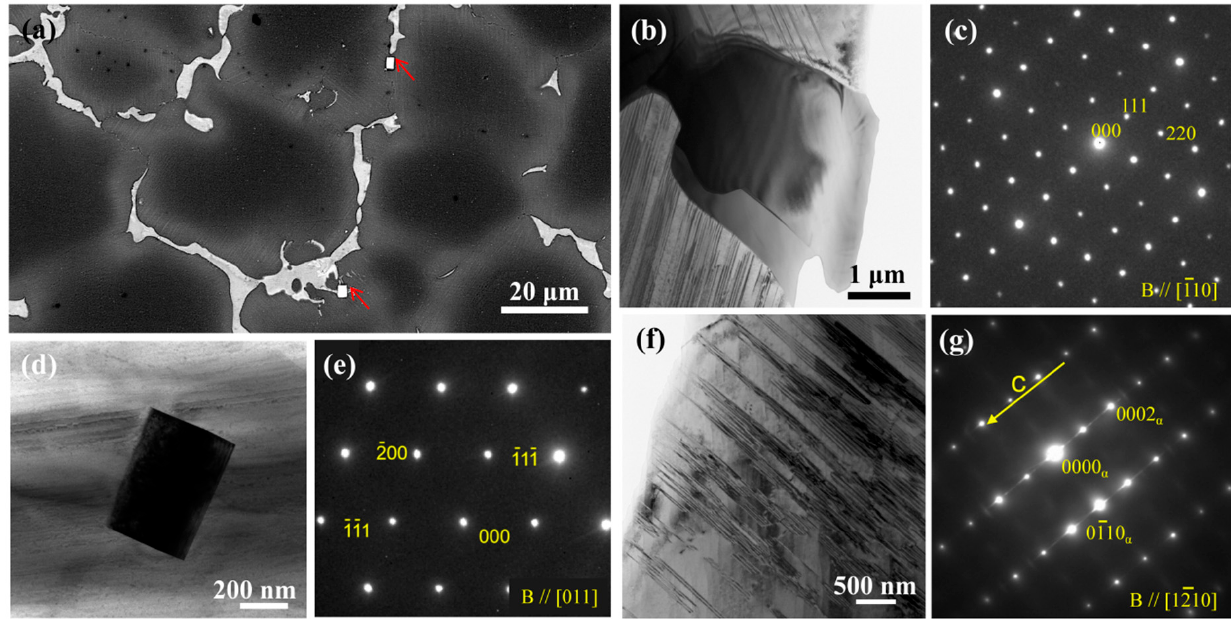
Figure 3. Initial microstructure of the as-cast EQ142X alloy: ( a ) SEM image; ( b – g ) bright-filed TEM images and corresponding SEAD patterns. Notes that red arrows marks square-phase particles and yellow arrow represent superstructured la tt ice.